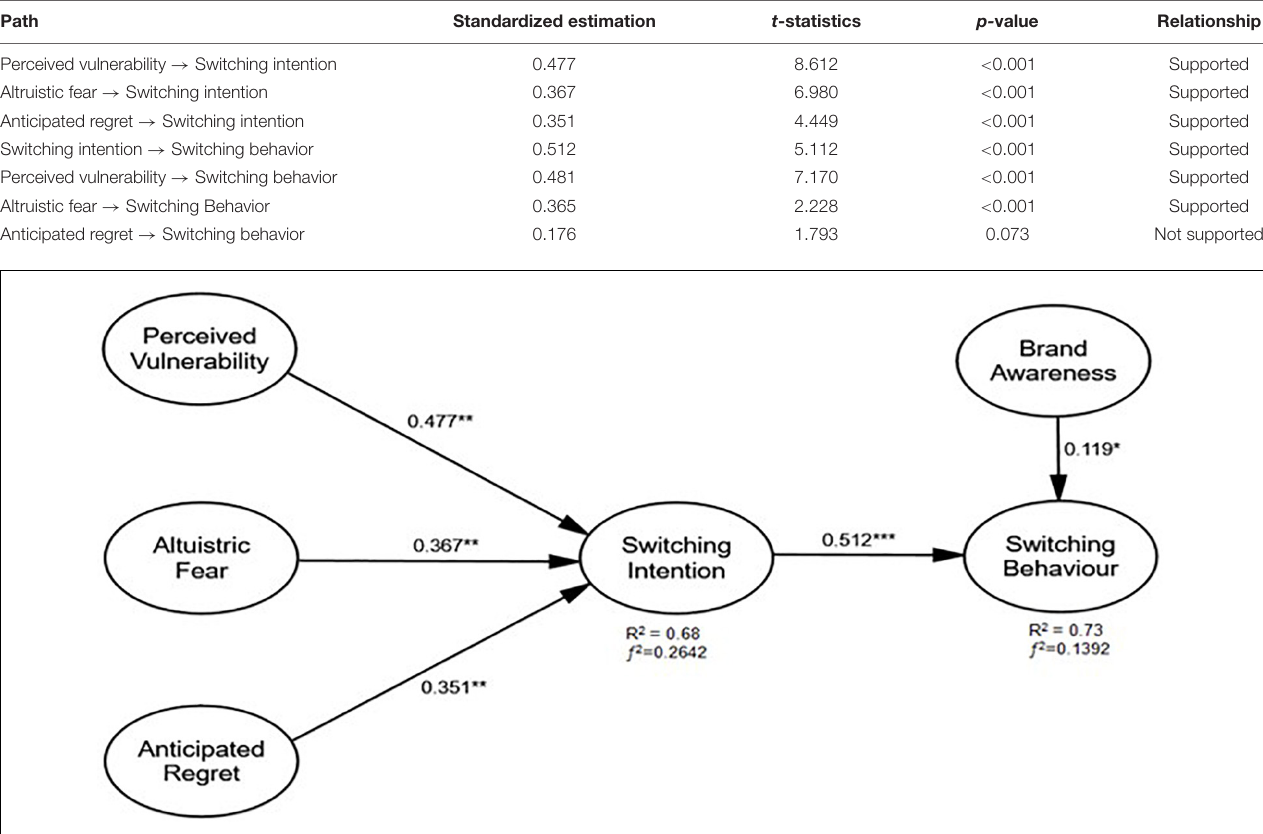
FIGURE 1 | Standardized structural equation parameter estimates. *, **, *** Level of significance at 10%, 5% and 1%